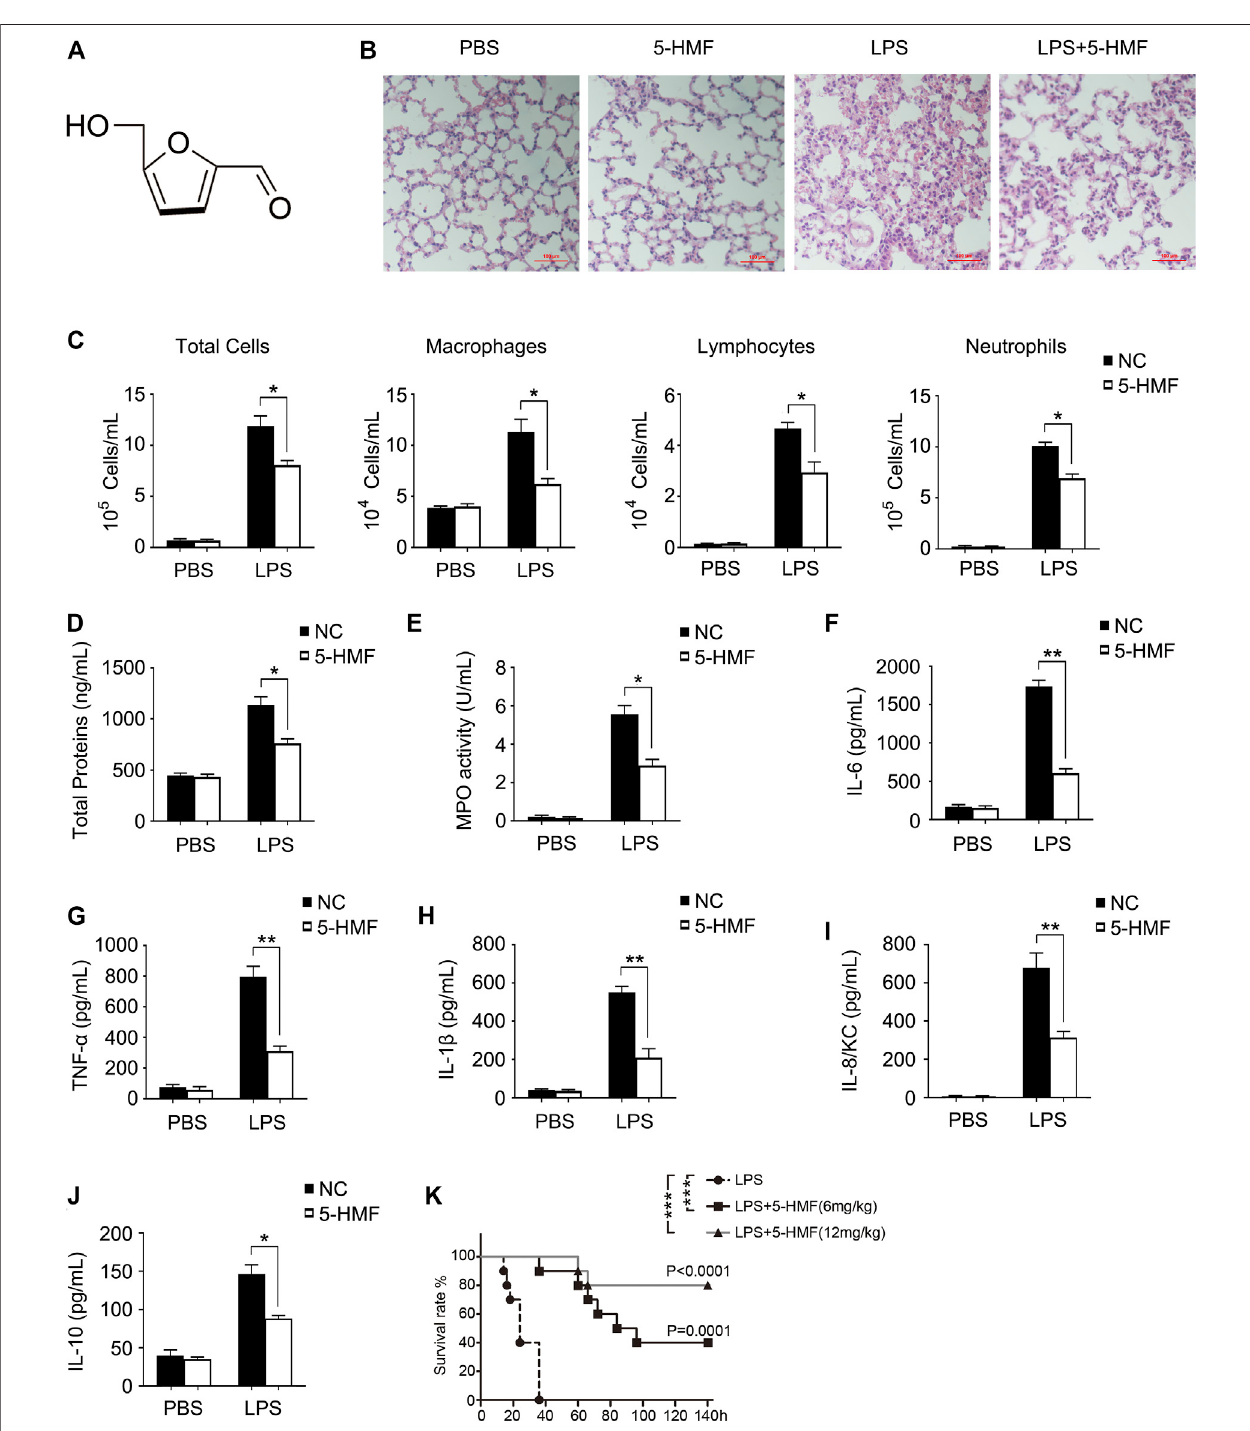
FIGURE1 | 5-HMF attenuates organ damage, serum cytokine secretion and mortality in LPS-challenged mice. (A) Chemical structure of5-HMF. (B – J) C57BL/6J mice(5mice/group)pretreatedwith5-HMF(12 mg/kg,i.p.)orPBSwereinjectedintraperitoneallywithLPS(1 mg/kg)orPBS. (B) RepresentativeimagesofH&Estained lung tissue sections from the indicated groups ( × 200), Scale bar, 100 μ m. (C) Cellular changes in BALF. (D) Protein content in BALF. (E) MPO activity of lung tissues. F – J) Serum levels of IL-6 (F) , TNF- α (G) , IL-1 β (H) , IL-8/KC (I) and IL-10 (J) . All results are expressed as the mean ± SD: * and ** indicate p < 0.05 and p < 0.01 respectively by Student ’ s t-test. (K) Kaplan − Meier survival plots of C57BL/6J mice (10 mice/group) injected intraperitoneally with LPS (25 mg/kg). Survival status was recorded for 6 days and data were analyzed using the Log-Rank test ( n (cid:2) 10 mice per group; ** p < 0.01).